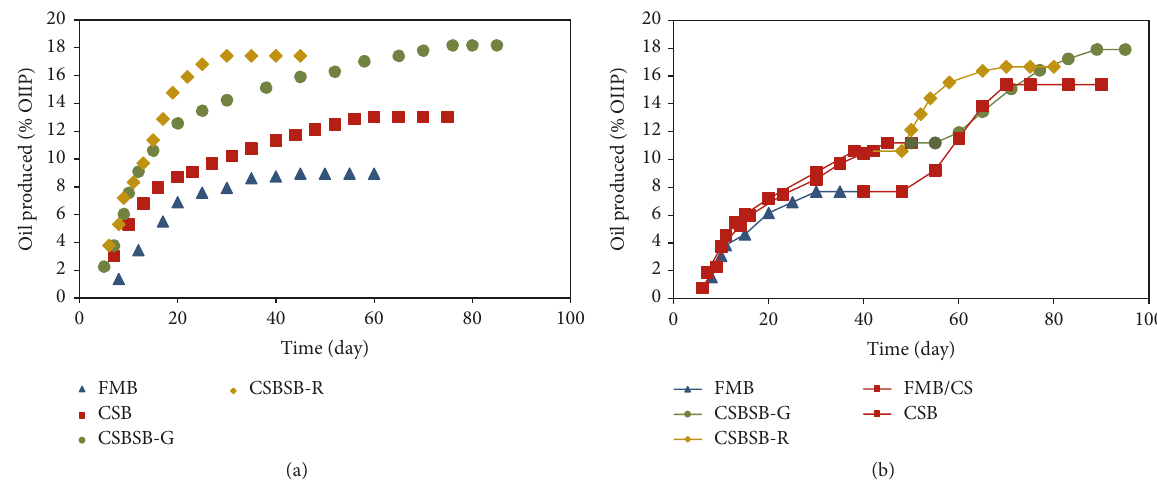
Figure 4: Rate of spontaneous imbibition of FMB (blue circle), CSB (dark red square), CSBSB-G (green rhombus), and CSBSB-R (golden triangle). Plot (a) shows rate of imbibition using single brine solution while (b) shows rate of imbibition with change in brine solutions.